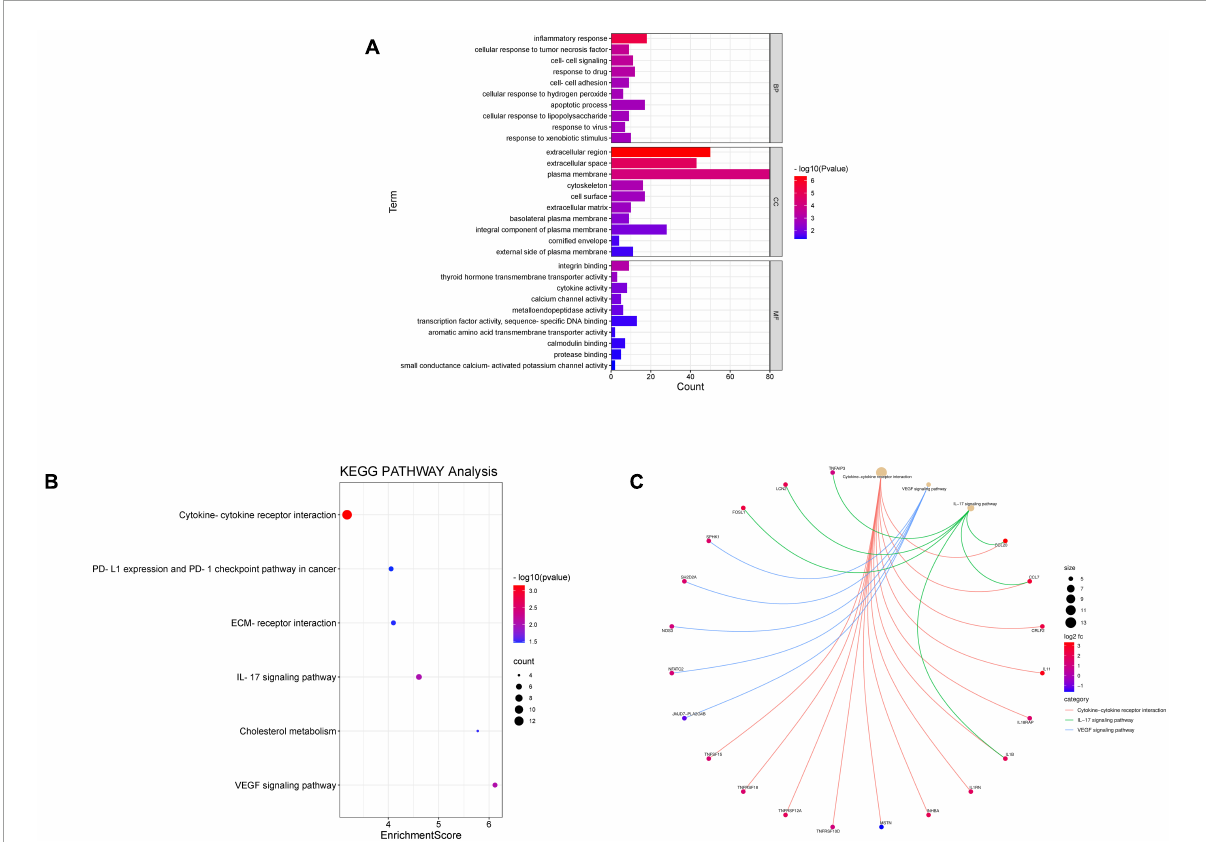
FIGURE3 Gene Ontology and KEGG pathway enrichment analysis of DEGs between diabetic and non-diabetic EAT. (A) The significant GO terms (biological process, cellular component, and molecular function) of 238 DEGs. (B) The significant KEGG pathway analysis of DEGs. P -value < 0.05. GO, Gene Ontology; KEGG, Kyoto Encyclopedia of Genes and Genomes. (C) Functional pathway analysis of corresponding genes and the top 3 related